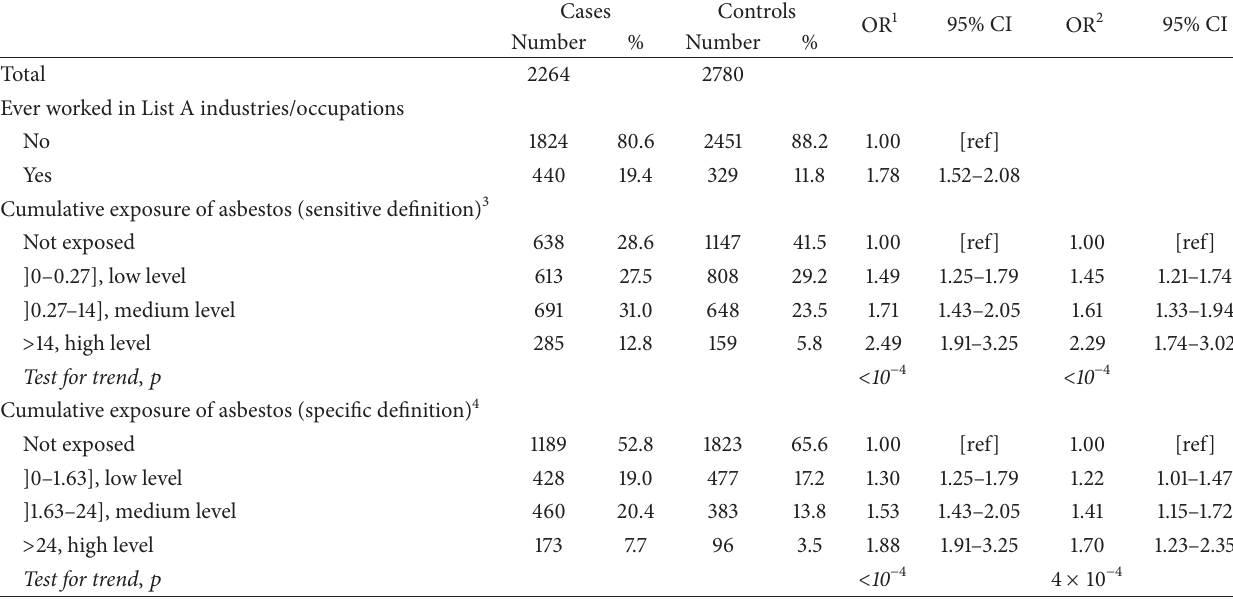
Table 2: OR of lung cancer according to previous occupational exposures and to asbestos.